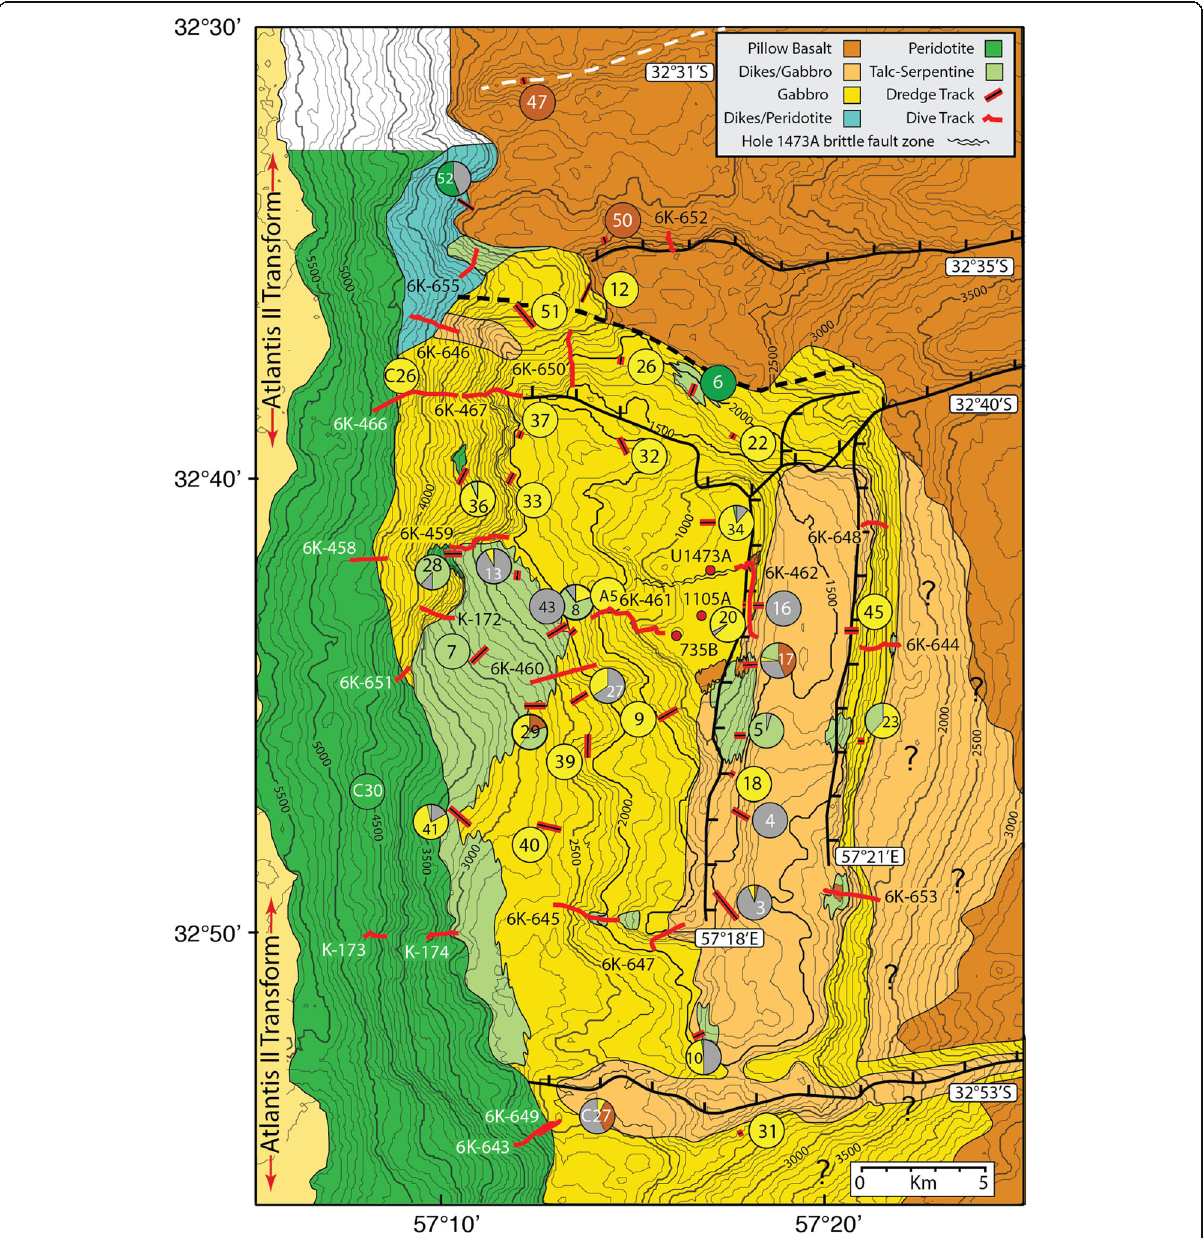
Fig. 3 Geologic Map of Atlantis Bank. Dive tracks are shown in solid red lines for the ROV Kaiko (K) and the Submersible Shinkai 6500. James Clark Ross Cruise 31 dredge tracks are shown by solid red lines with a central black line with rock proportions shown by adjacent pie diagrams without a letter prefix. Dashed white line shows location of old axial volcanic ridge. Dashed black line indicates the secondary detachment fault termination. The pillow lavas to the north cover the primary detachment fault termination. Locations of ODP Holes 735B and 1105A, and IODP U1473A are shown by red dots. Pie diagrams with letter prefixes mark starting dredge location. C stands for RV Conrad Cruise 27, Leg 9, and A stands for RV Atlantis II Cruise